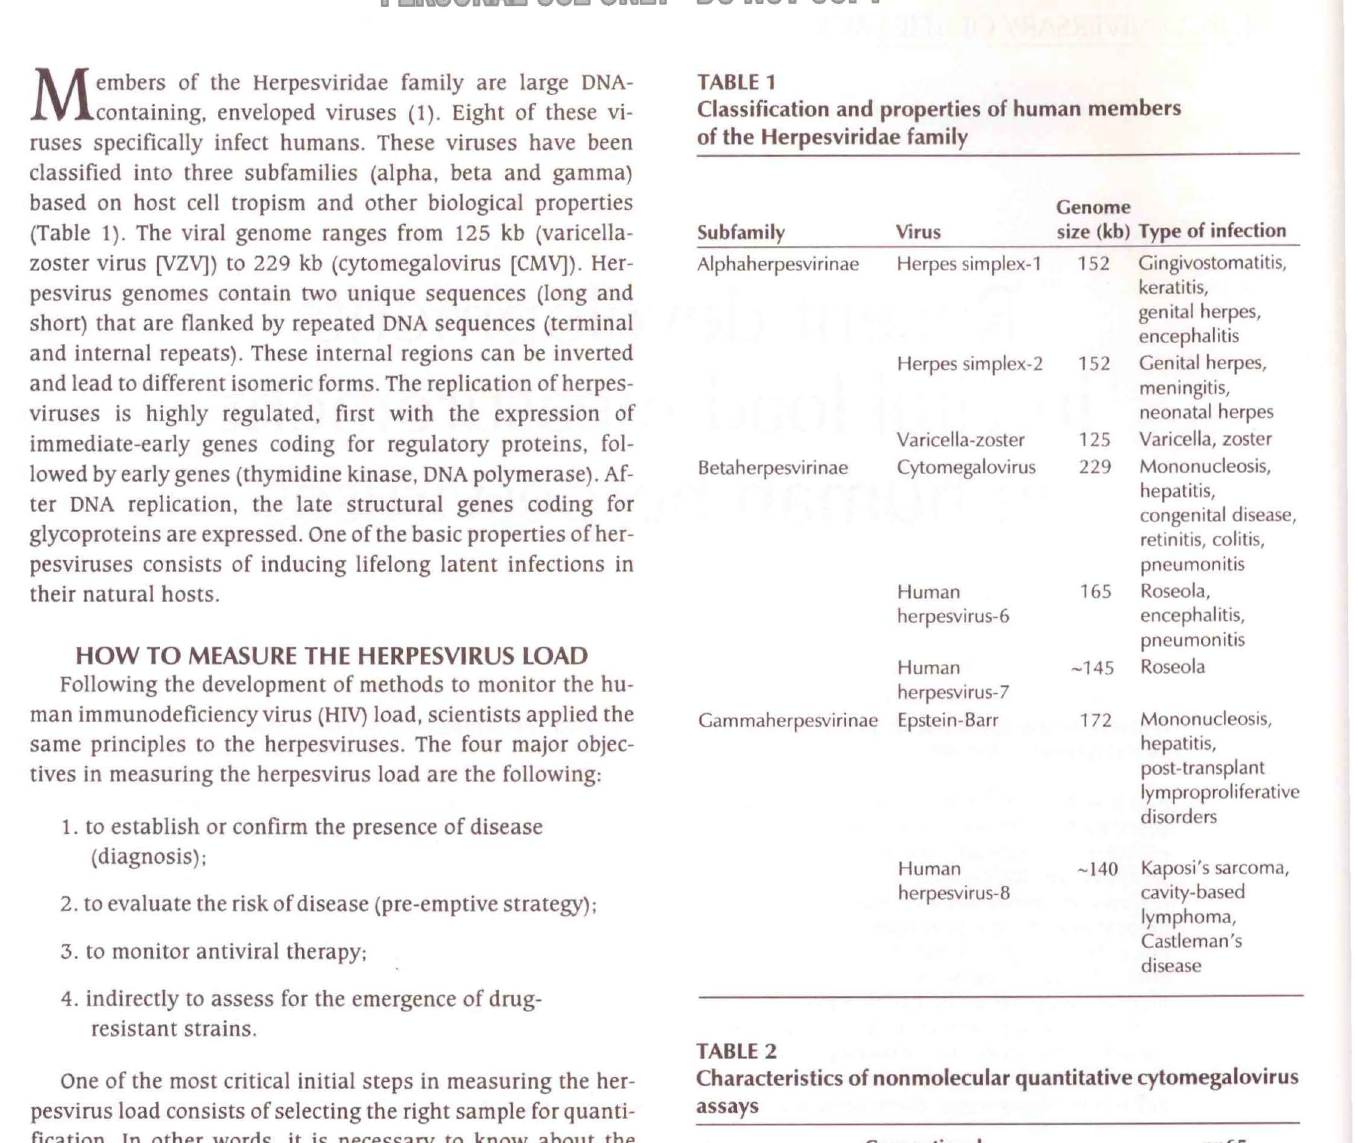
Characteristics of non molecular quantitative